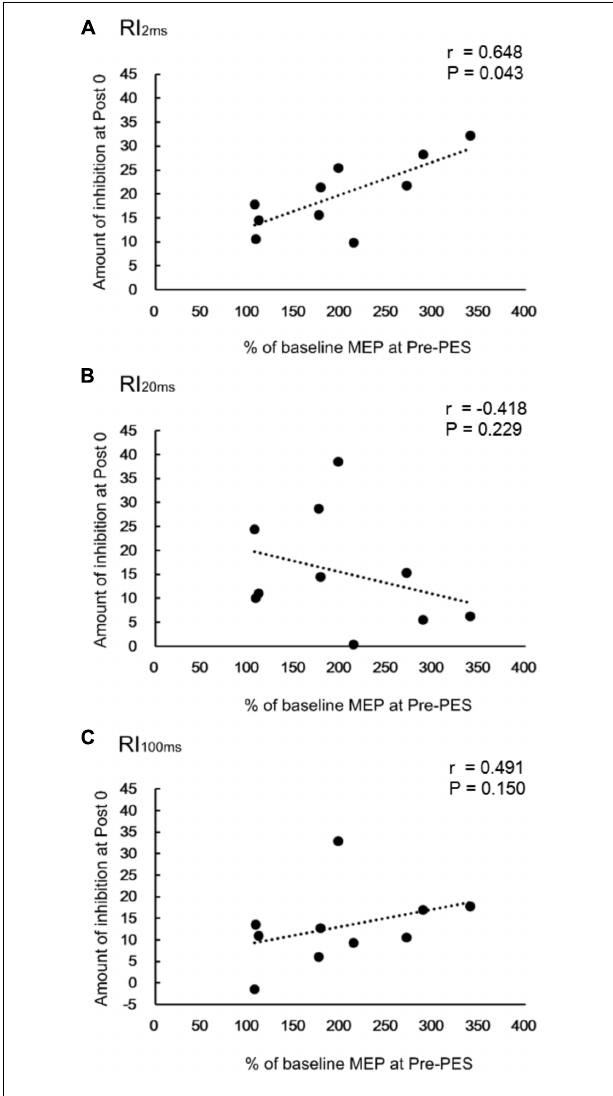
FIGURE 4 | Correlations between change in reciprocal inhibition (RI) and MEPs. Correlation between percent changes in RI 2ms (A) , RI 20ms (B) , and RI 100ms (C) at Post0 time-point and the normalized MEPs in the TA muscle, for the iTBS-before-PES